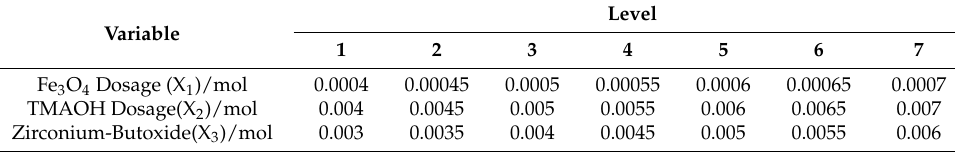
Table 3. Dose for selected parameters.